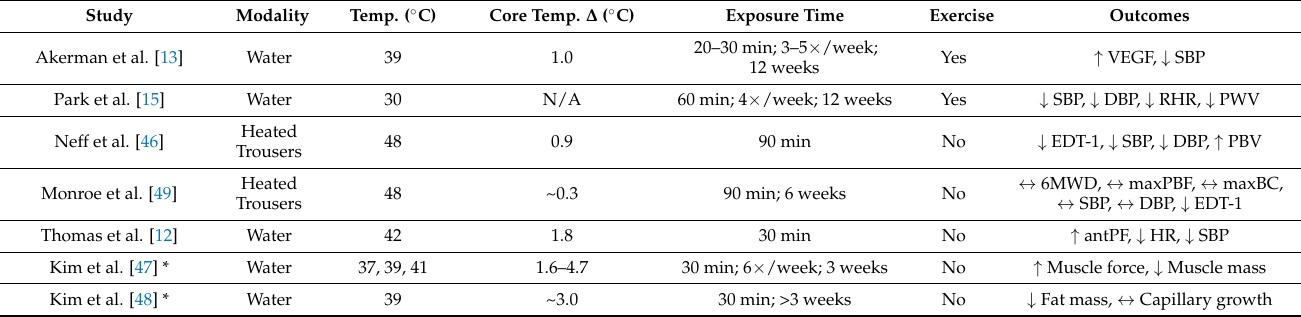
Table 2. Characteristics of the heat therapy studies in patients with peripheral artery disease (PAD) and chronic hindlimb is- chemia murine models. The asterisk (*) indicates animal studies. (VEGF—vascular endothelial growth factor; SBP— systolic blood pressure; DBP—diastolic blood pressure; RHR—resting heart rate; PWV—pulse wave velocity; EDT-1—endothelin- 1; PBV—popliteal blood velocity; 6MWD—6 minute walk distance; maxPBF—maximum popliteal artery blood